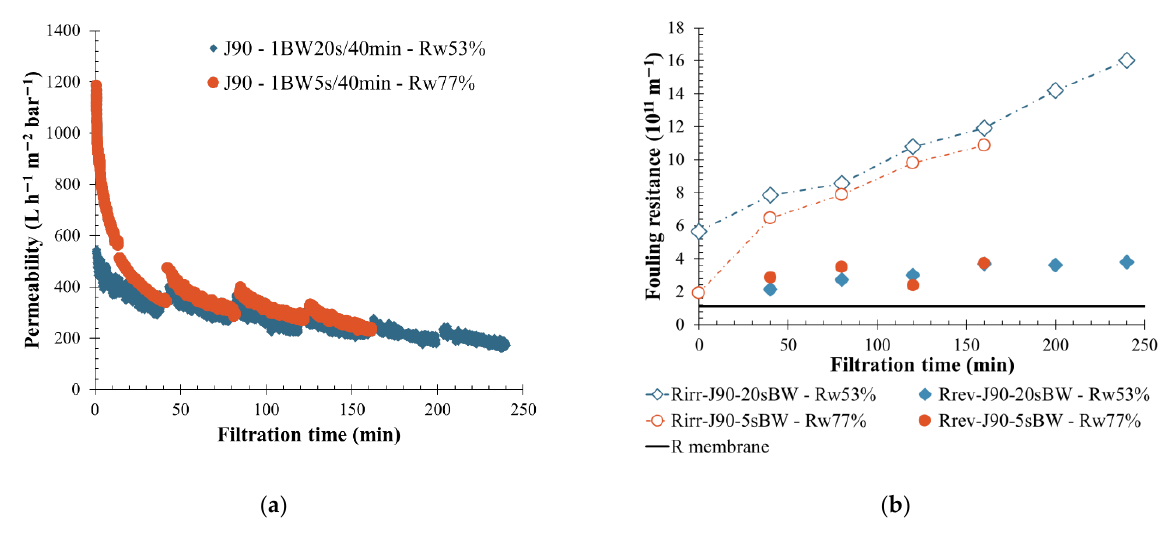
Figure 7. Influence of BW duration on membrane filtration behavior by variation of permeability at 20 ◦ C ( a ) and fouling resistance ( b ) throughout the time to permeate flux of 90 L h − 1 m − 2 , a BW interval of 40 min and a BW duration of 5 s (orange round) and 20 s (blue diamond) are applied to the membrane. T = 20 ◦ C, feedwater from APL-VANDA-ME; SiC membrane 0.33 m 2 . Jxx is permeate flux at the xx value in L h − 1 m − 2 ; 1BW yy s/zz min where yy is the duration and zz the interval of filtration between two BF; and Rw is the total recovery rate applied on the unit; R irr is irreversible resistance; R rev is reversible resistance and R membrane is the membrane resistance.